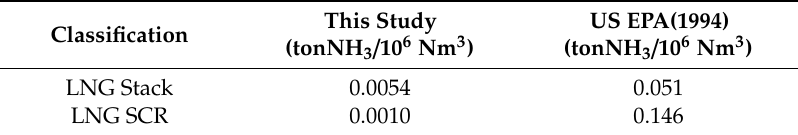
Table 4. NH 3 emission factor of the investigated LNG power plant.